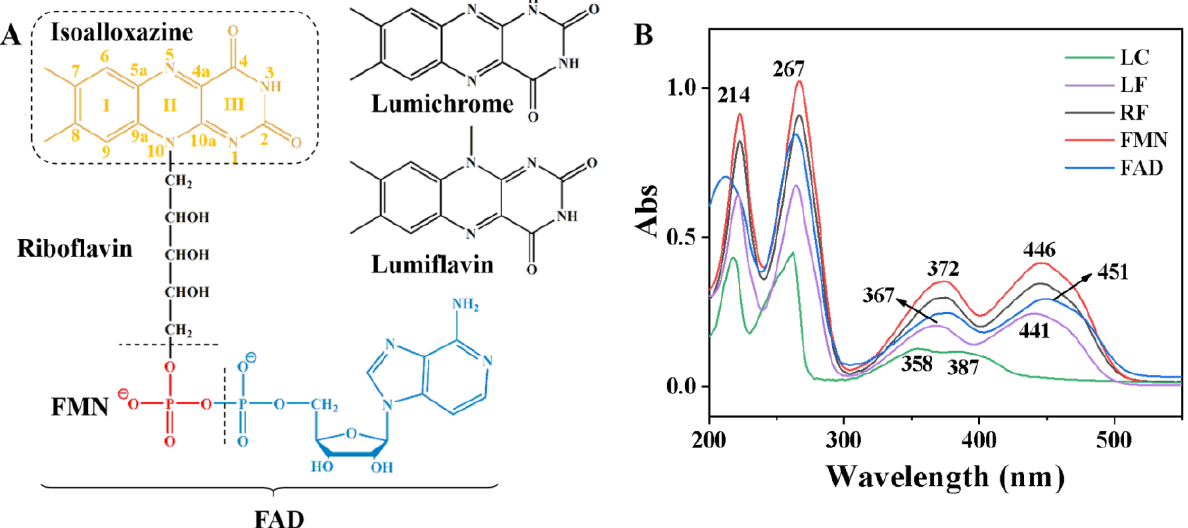
Figure 1. ( A ) Structures of lumichrome (LC), lumiflavin (LF), riboflavin (RF), flavin mononucleotide (FMN) and flavin adenine dinucleotide (FAD); ( B ) UV absorption spectra of LC, LF, RF, FMN, and FAD .